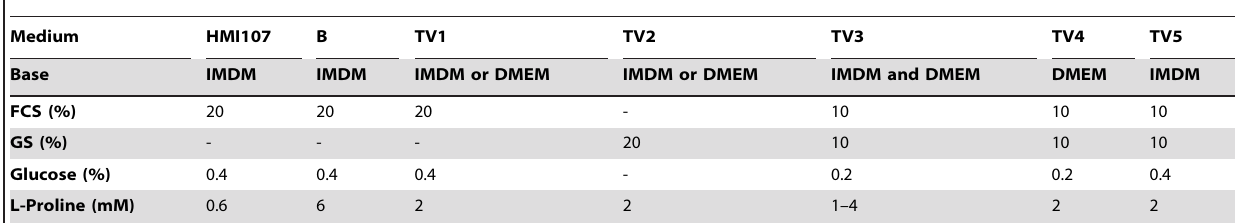
Table 1. Parasite culture media.